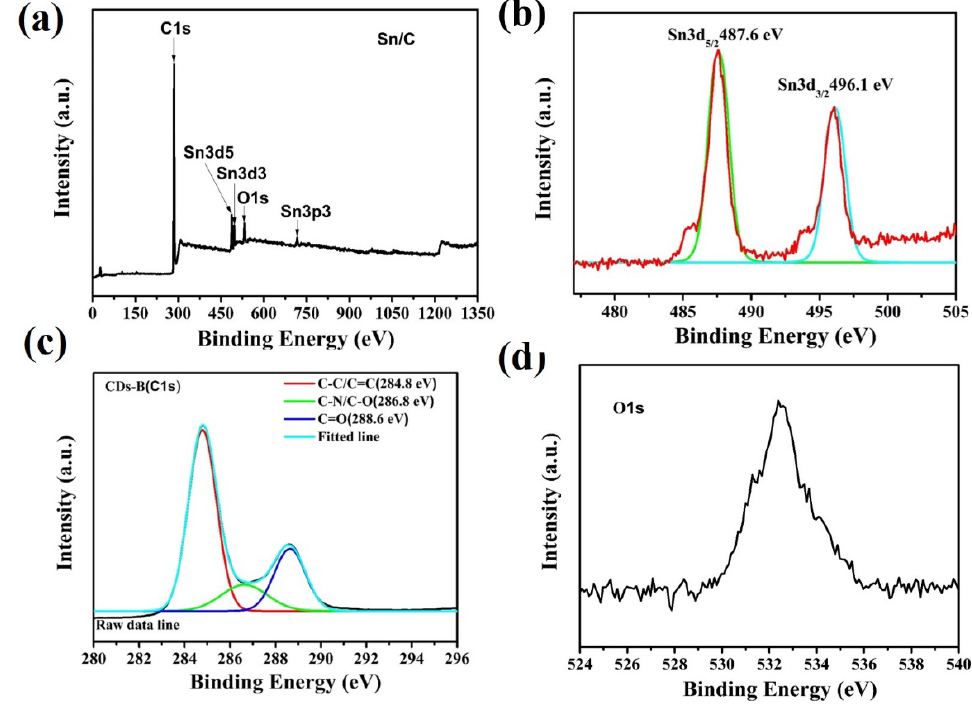
Figure 2. XPS spectra of Sn/C: ( a ) survey scan; ( b ) Sn3d spectra; ( c ) C1s spectra; ( d ) O1s spectra.